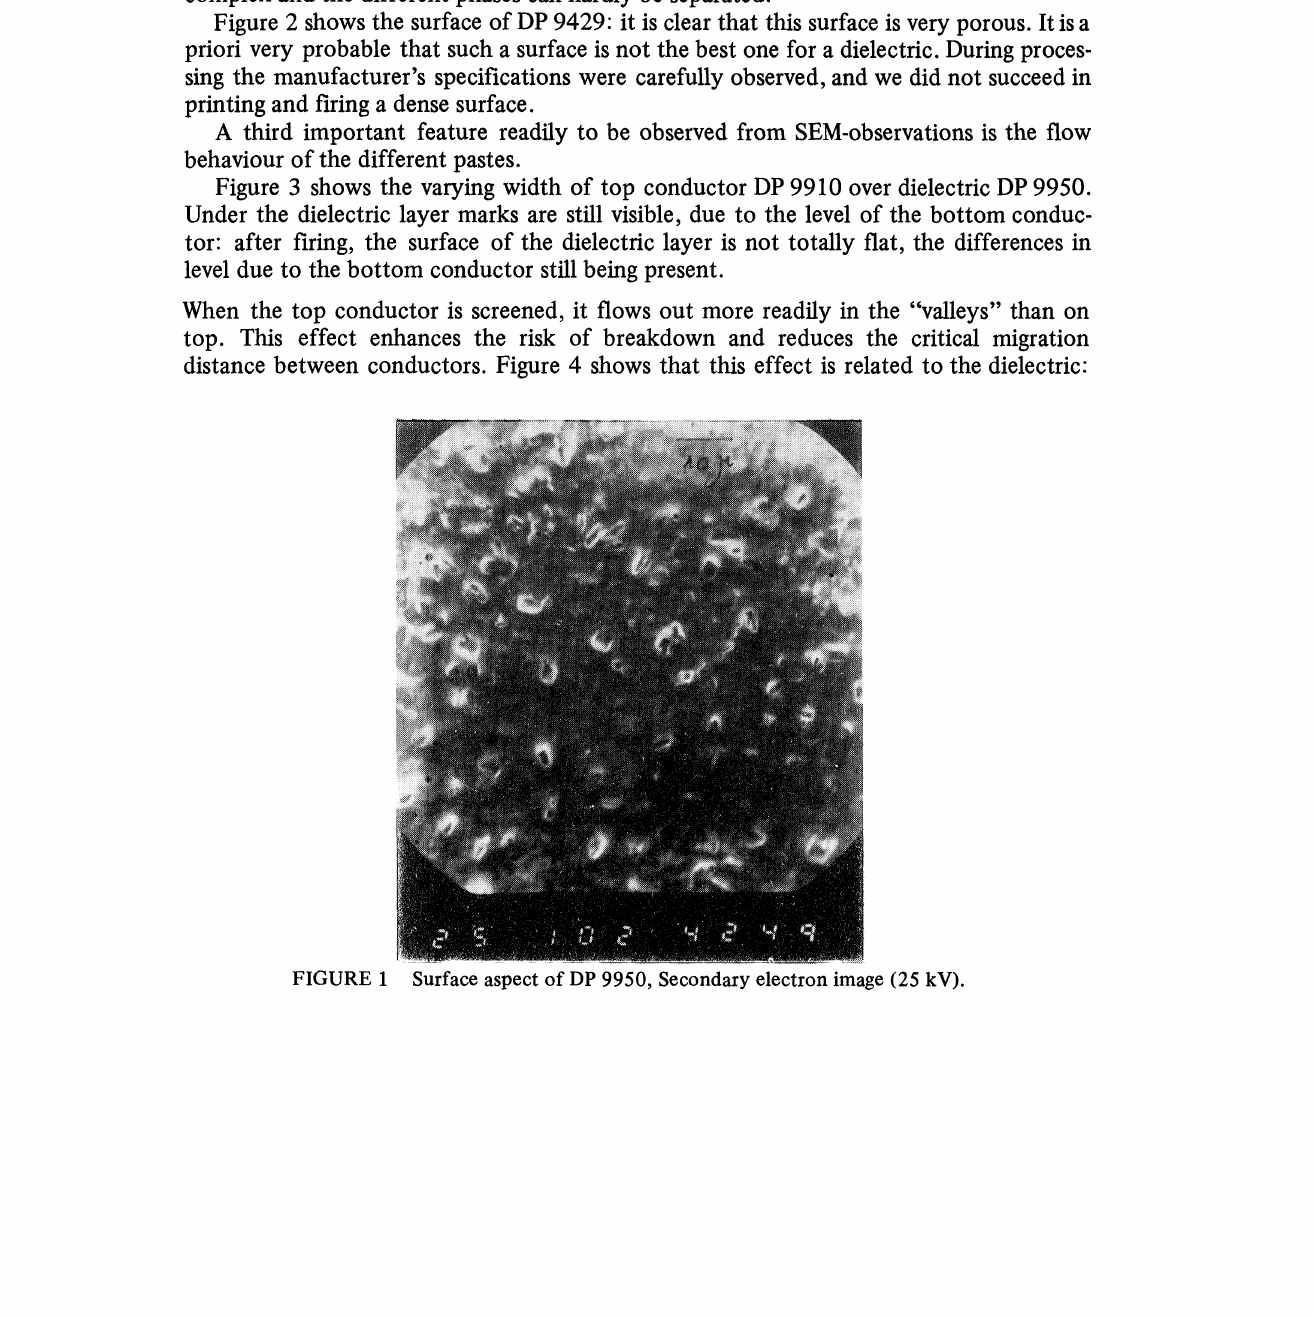
FIGURE Surface aspect of DP 9950, Secondary electron image (25